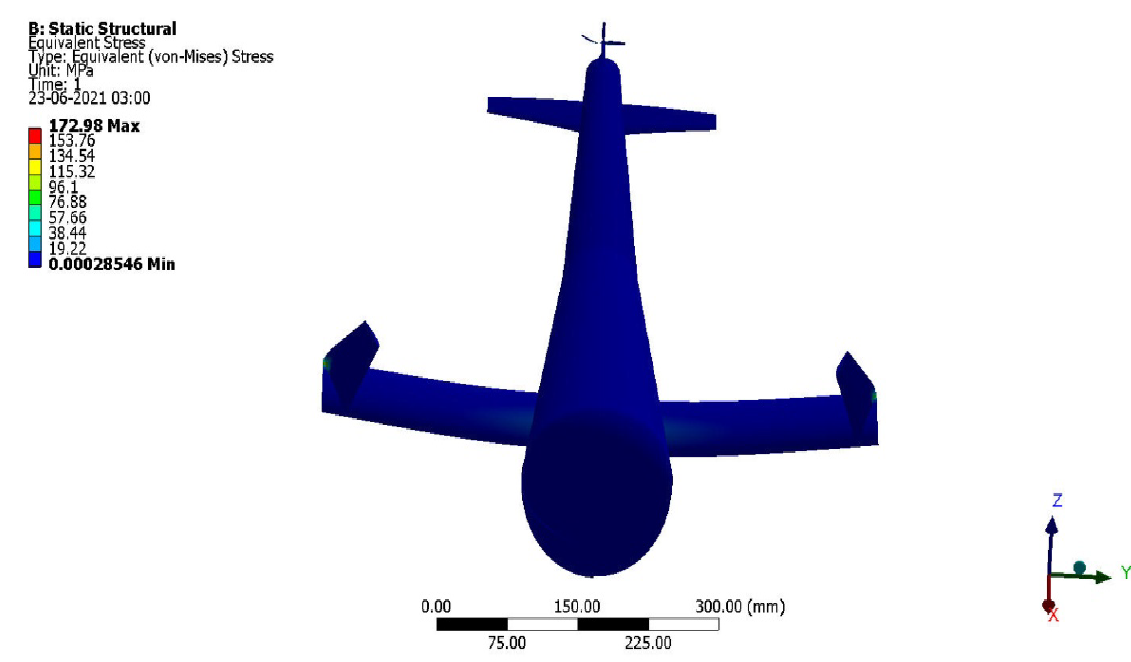
Figure 38. Equivalent Stress of GFRP-W-FR-4 based optimised UAV.